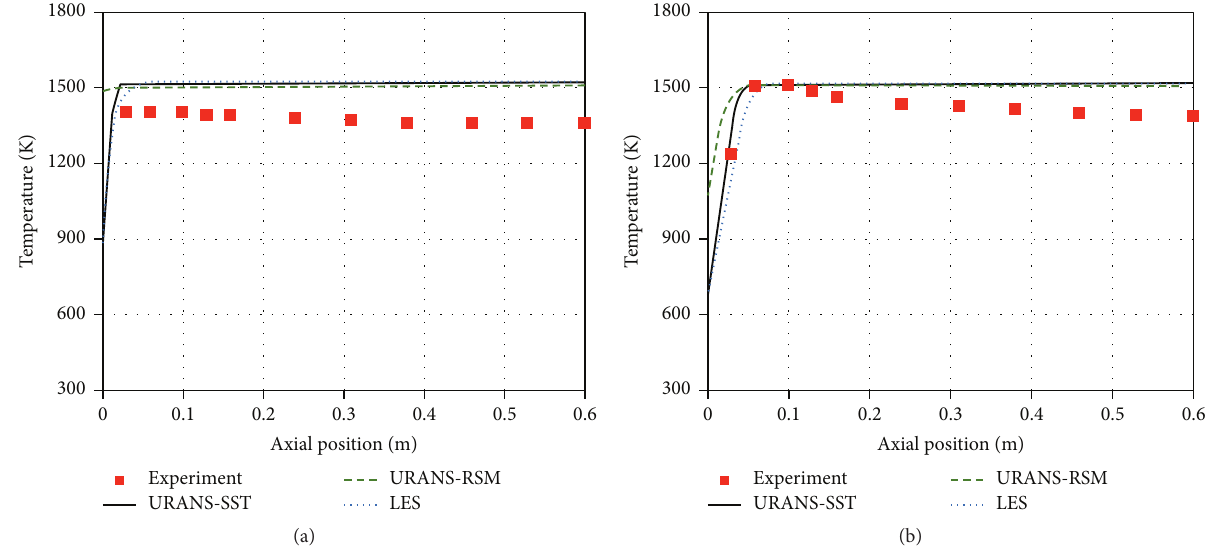
Figure 10: Predicted and measured profiles of time-averaged temperature along (a) combustor axis and (b) evaluation line for NG-FGR20 flame.